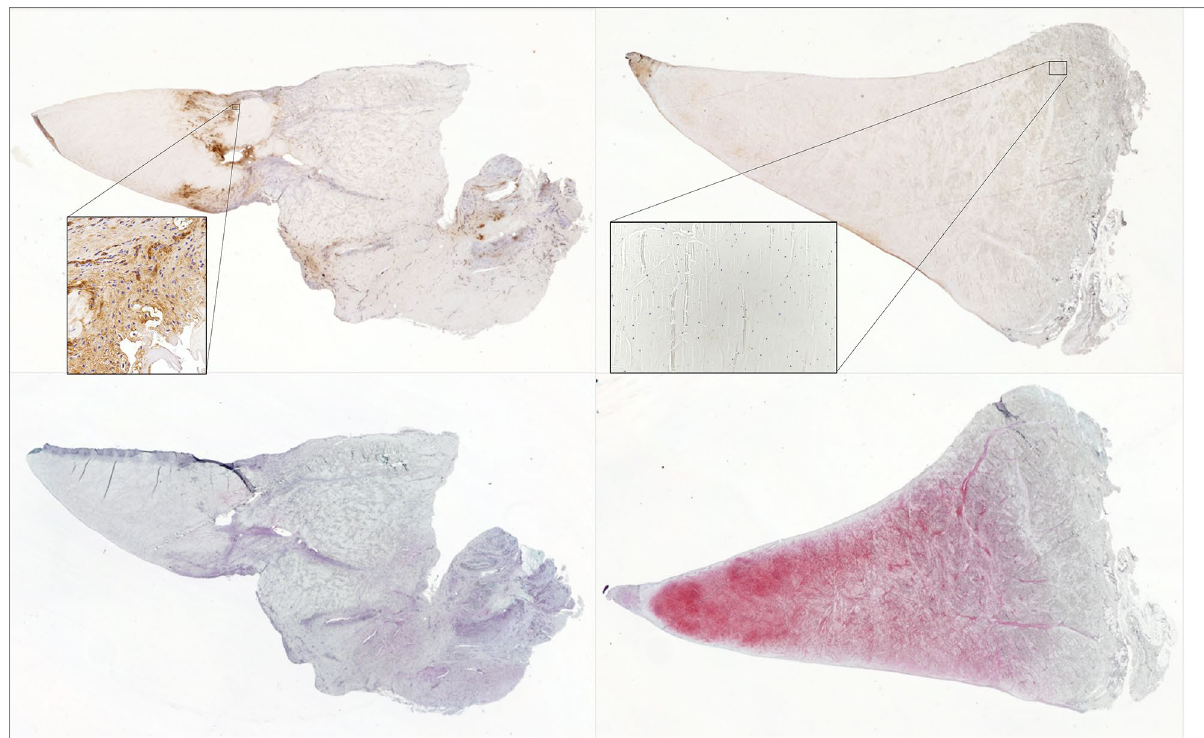
Figure 4. Comparison of sutured section six weeks post-operative with contralateral control. Serial sections were immunostained with factor VIII-related antigen (top images); the reaction product is brown. Insets demonstrate vessels with endothelial cells positive for factor VIII-related antigen (top left) and area containing no vessels (top right). Complete tissue sections are 1 × objective and insets are 20 × objective. Additional sections were stained with safranin-O (bottom images); red staining indicate the presence of proteoglycans.